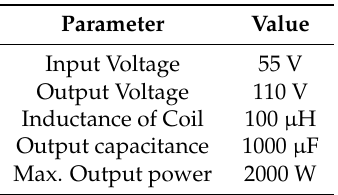
Table 1. Parameters of power